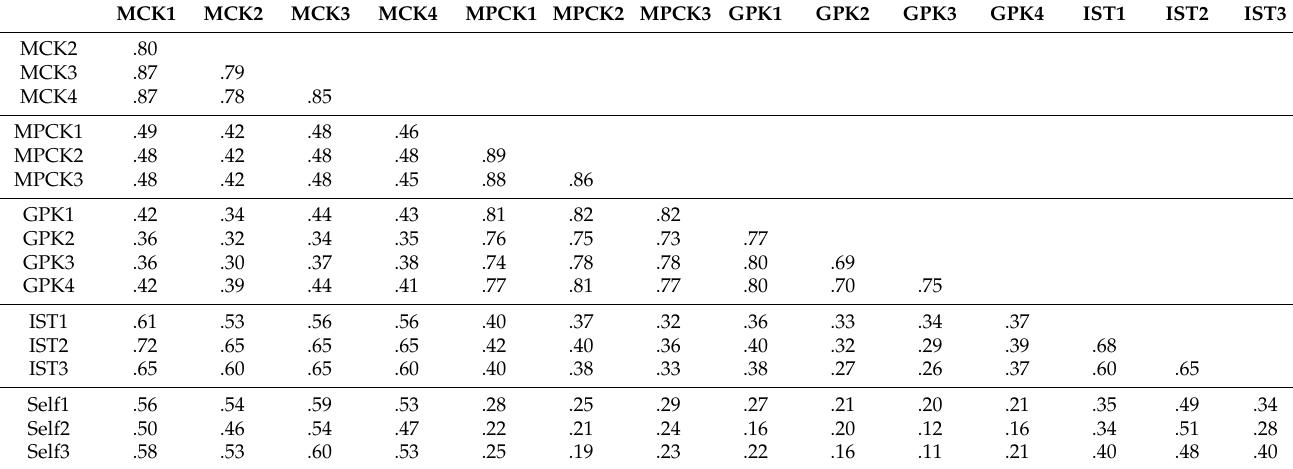
Table 1. Correlations between all